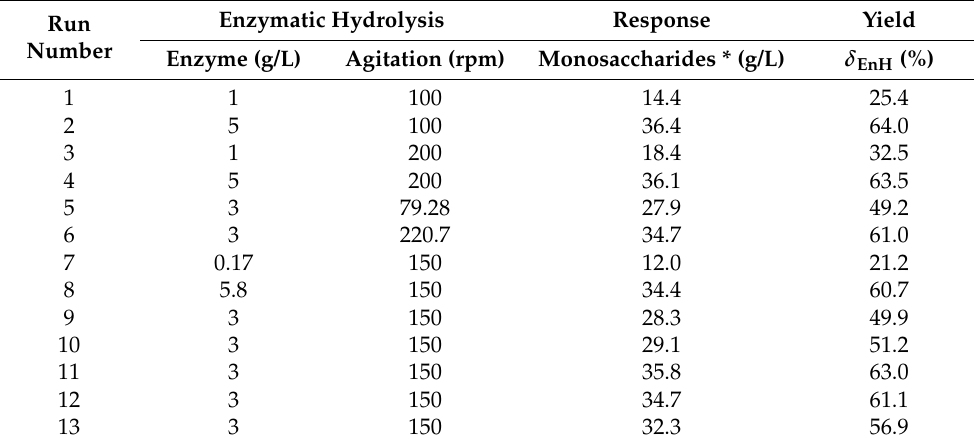
Table 3. Central composite design for enzymatic hydrolysis, concentration of monosaccharides, and yield.